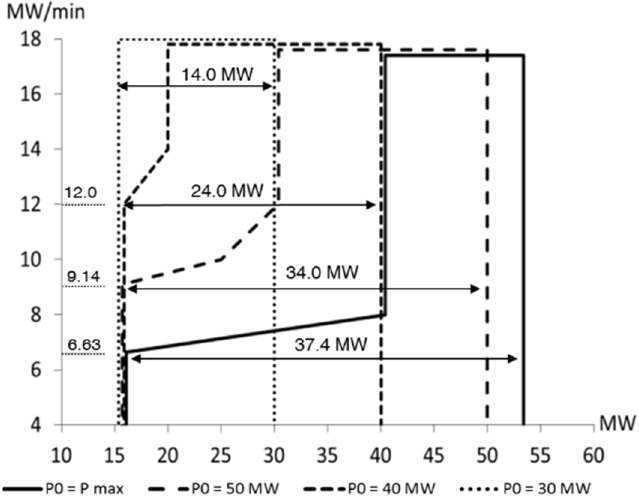
Figure 12. Ramp limits or maximum power bands for secondary LFC, for an initial reservoir level of 132.5 masl, present governor settings and different initial output powers